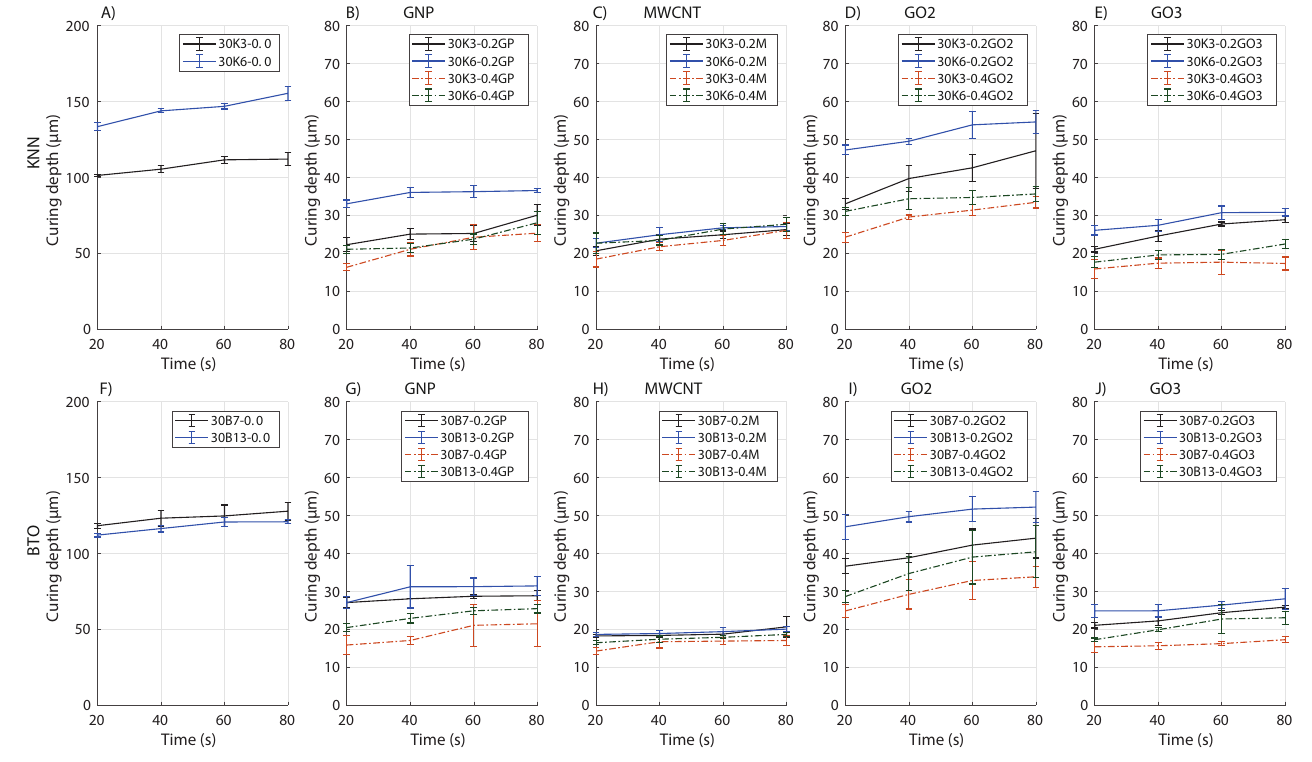
Figure 1. Curing depth over curing time of all composites manufactured in the study at room temperature. The addition of ceramic particles to the photopolymer reduces curing depths because ceramic particles block and scatter UV light [75,89,90]. Curing depth reduction is mainly dependent on ceramic loading (kept constant in this study) and the difference in refractive index between photopolymer and ceramic particles used [50,75,76,87–90,107–109].